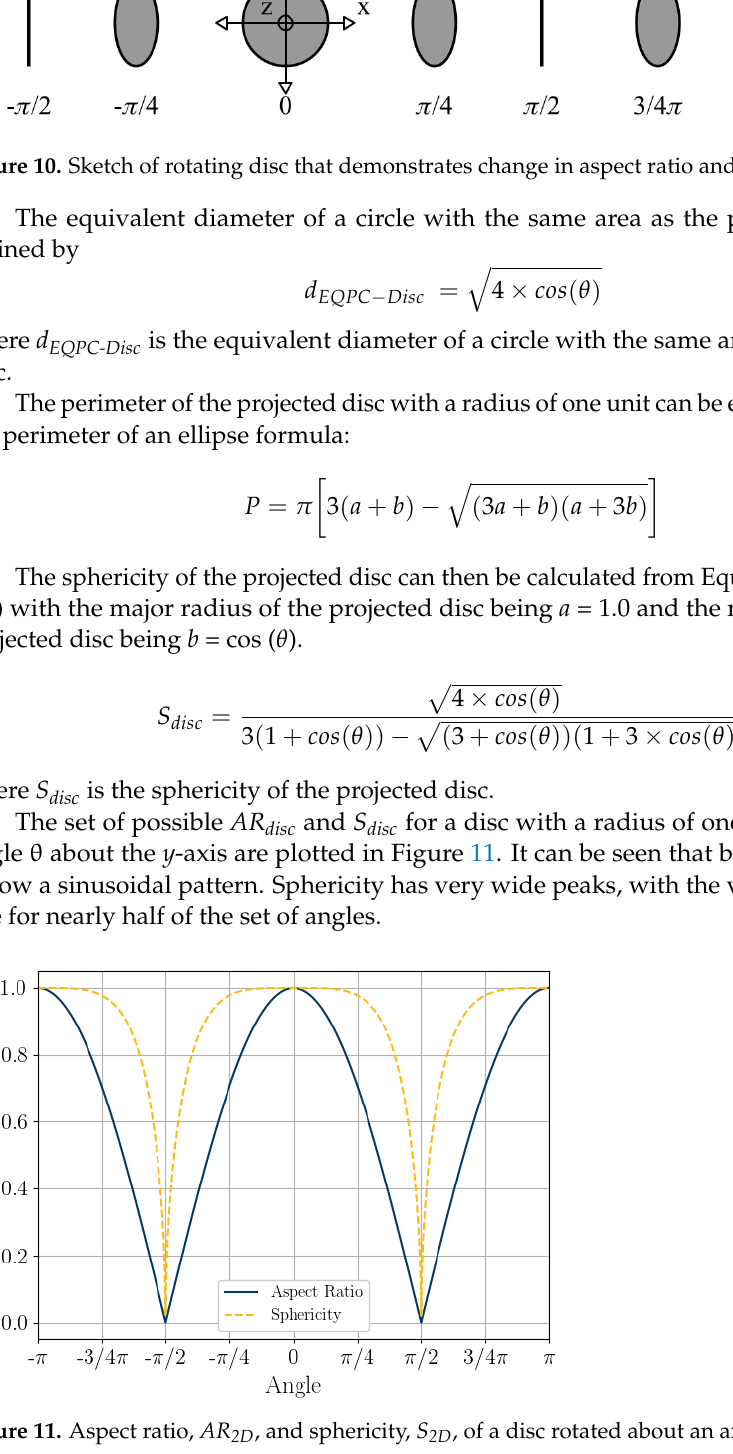
The 2D DIA imaging of a grain falling in front of an imaging sensor at a random angle can be modelled by randomly sampling Equations (12) and (15) at 10,000 random angles θ about the y -axis and plotting the probability density, as in Figure 12. Rotation about the x-axis would follow the same formulations presented above due to the disc